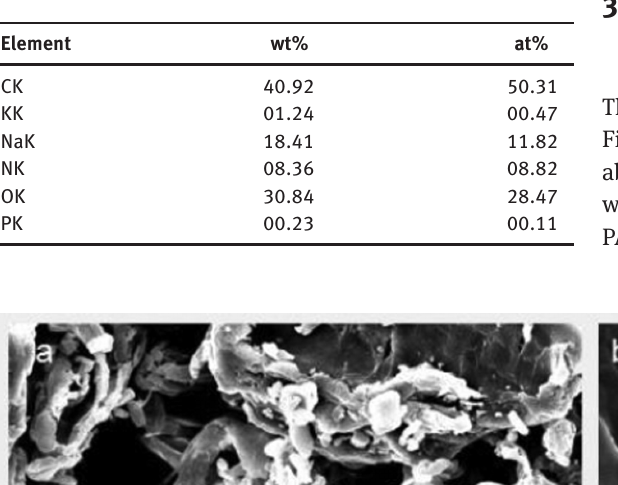
Table 2: Weight percent and atomic percentage of each element in SC-g-PAA/PAM/Urea.